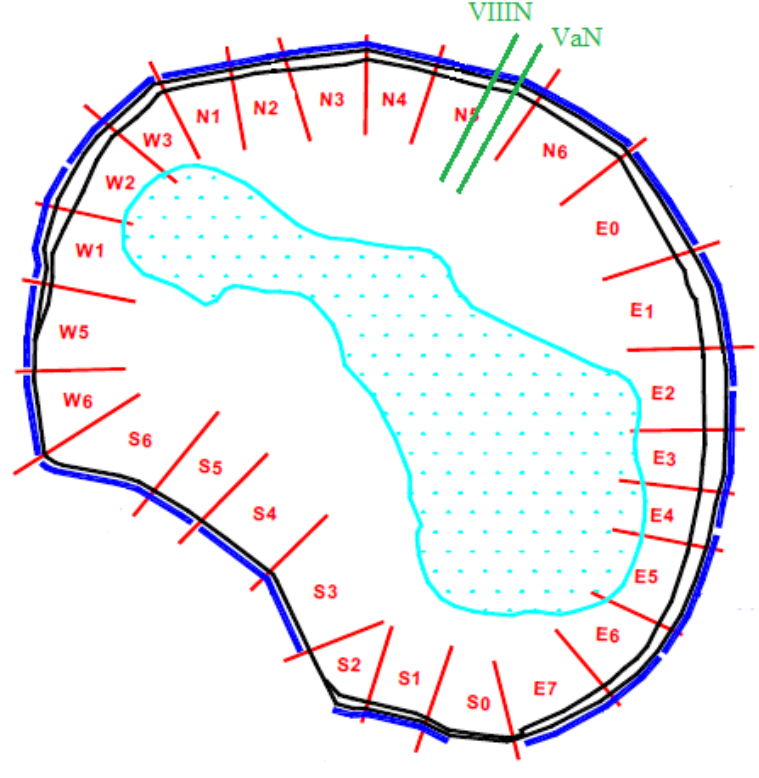
Figure 4: Technological sections (red) and cross-sections (green) selected for analysis.